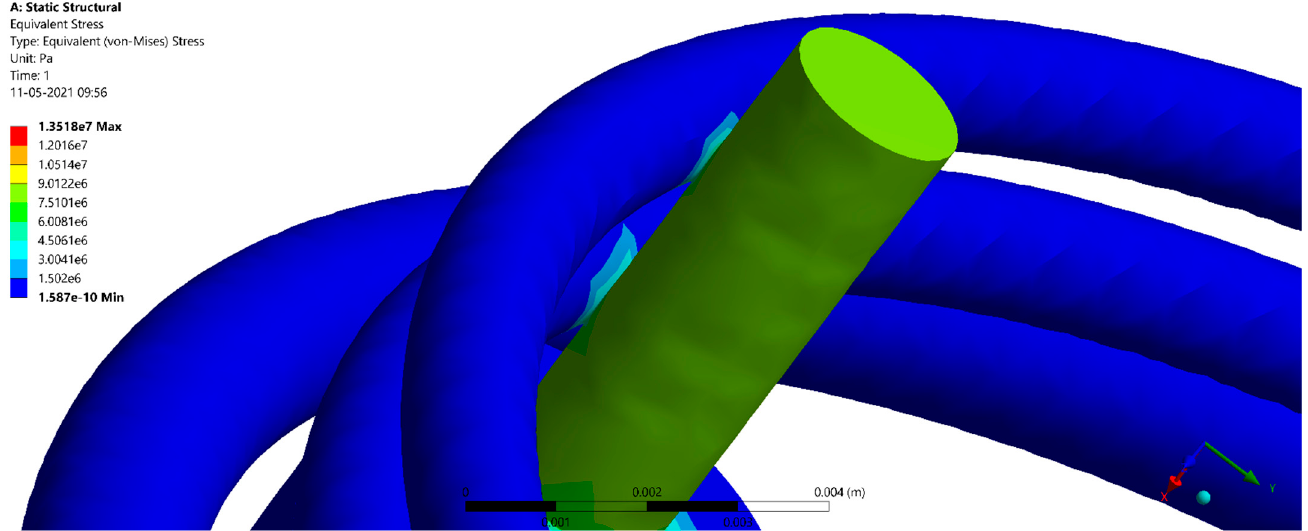
Figure 3. Stress dissipated along the fences. Table 4. Deformation Values for an Angular Load of 100 N. Table 3. Stress Values for Titanium Framework .